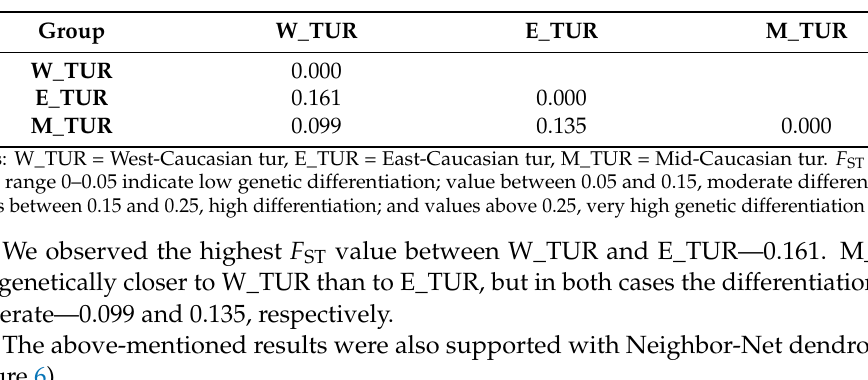
Table 2. Genetic diversity in the groups of Caucasian tur ( Capra caucasica ).